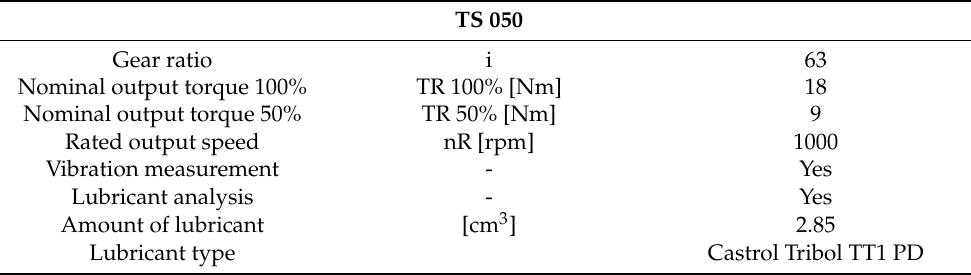
Table 1. Conditions of measurements applied to TS